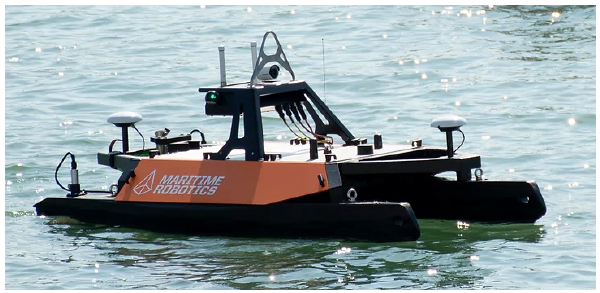
Figure 1: The Otter USV. Image courtesy by Maritime Robotics